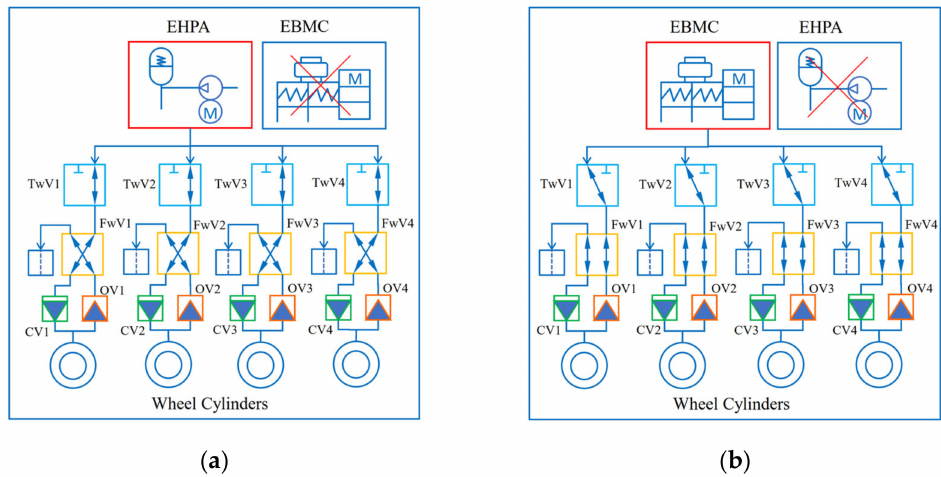
Figure 3. Degraded initiative braking F1 modes. F1 represents for the braking failure type 1 in hydraulic power provider layer. ( a ) Braking with EBMC failure; ( b ) Braking with EHPA failure.